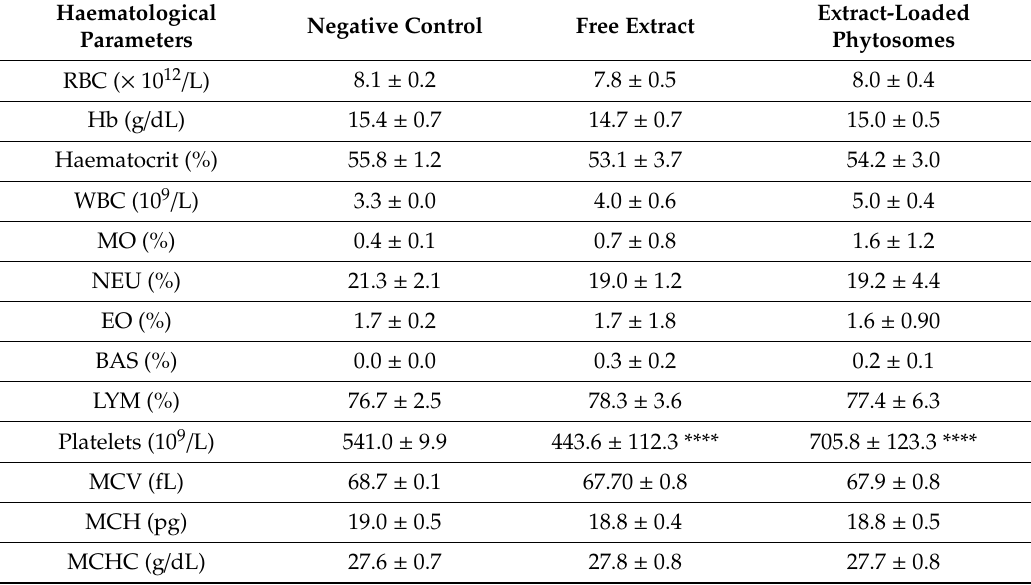
Table 6. The haematological parameters after 15 days of oral administration. The data has been expressed by the means ±